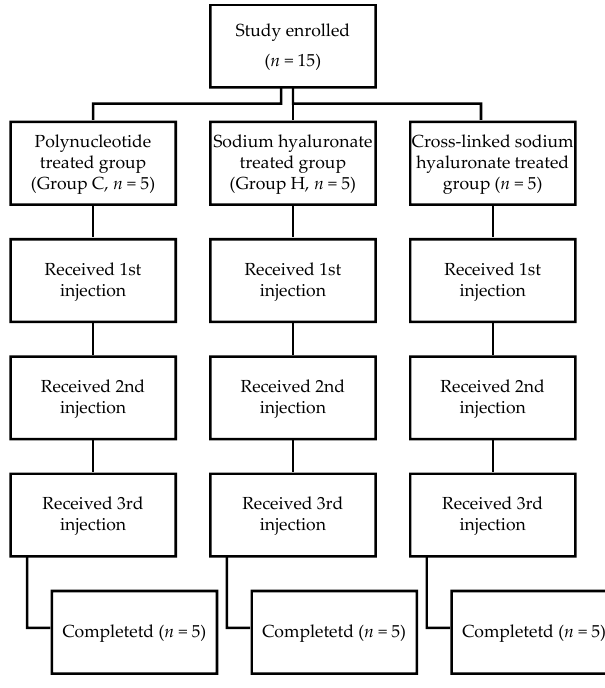
Figure 1. Diagram of the study protocol.